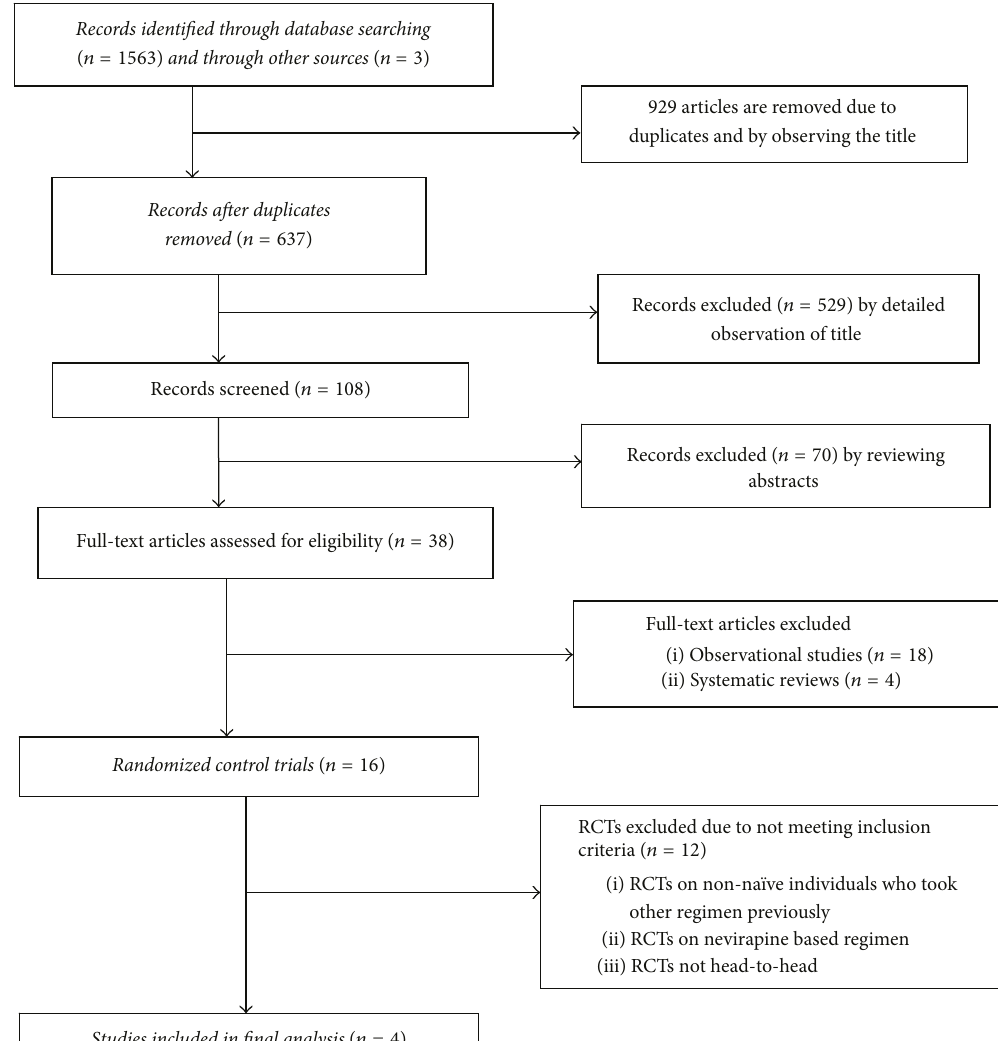
Figure 1: Flow chart of study